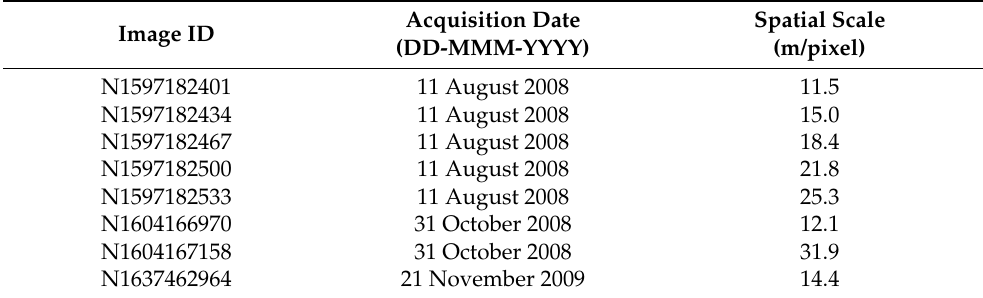
Table 1. Image ID, acquisition date and spatial scale of the Cassini ISS-NAC images used in this